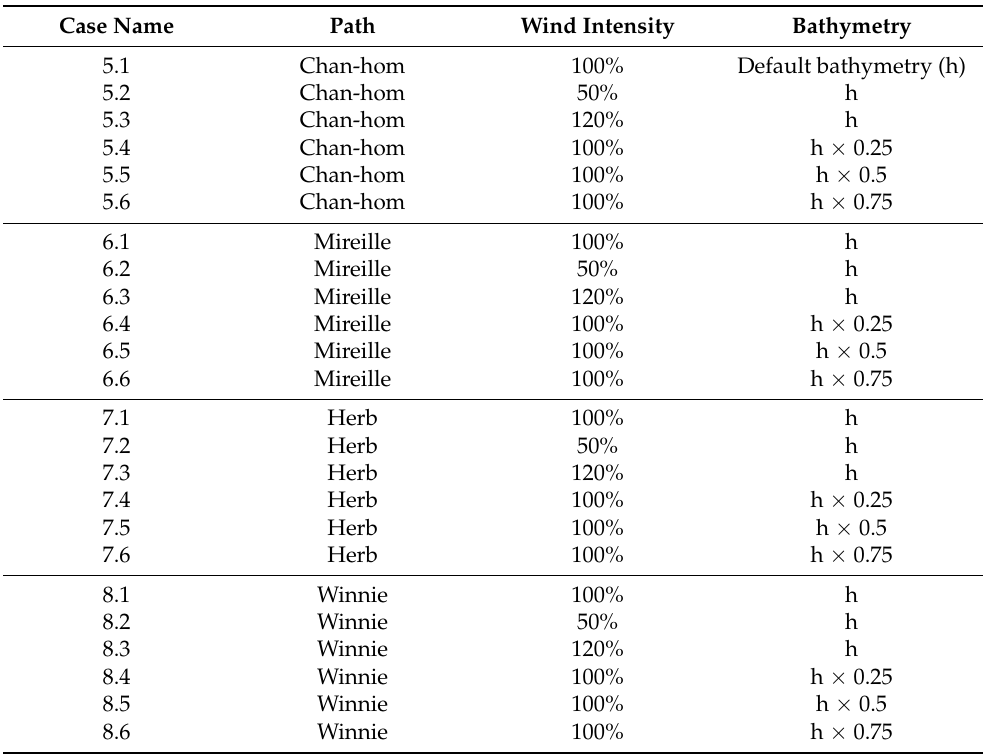
Table 4. Settings of sensitivity experiments to explore the effects of typhoon path, wind intensity, and topography on storm